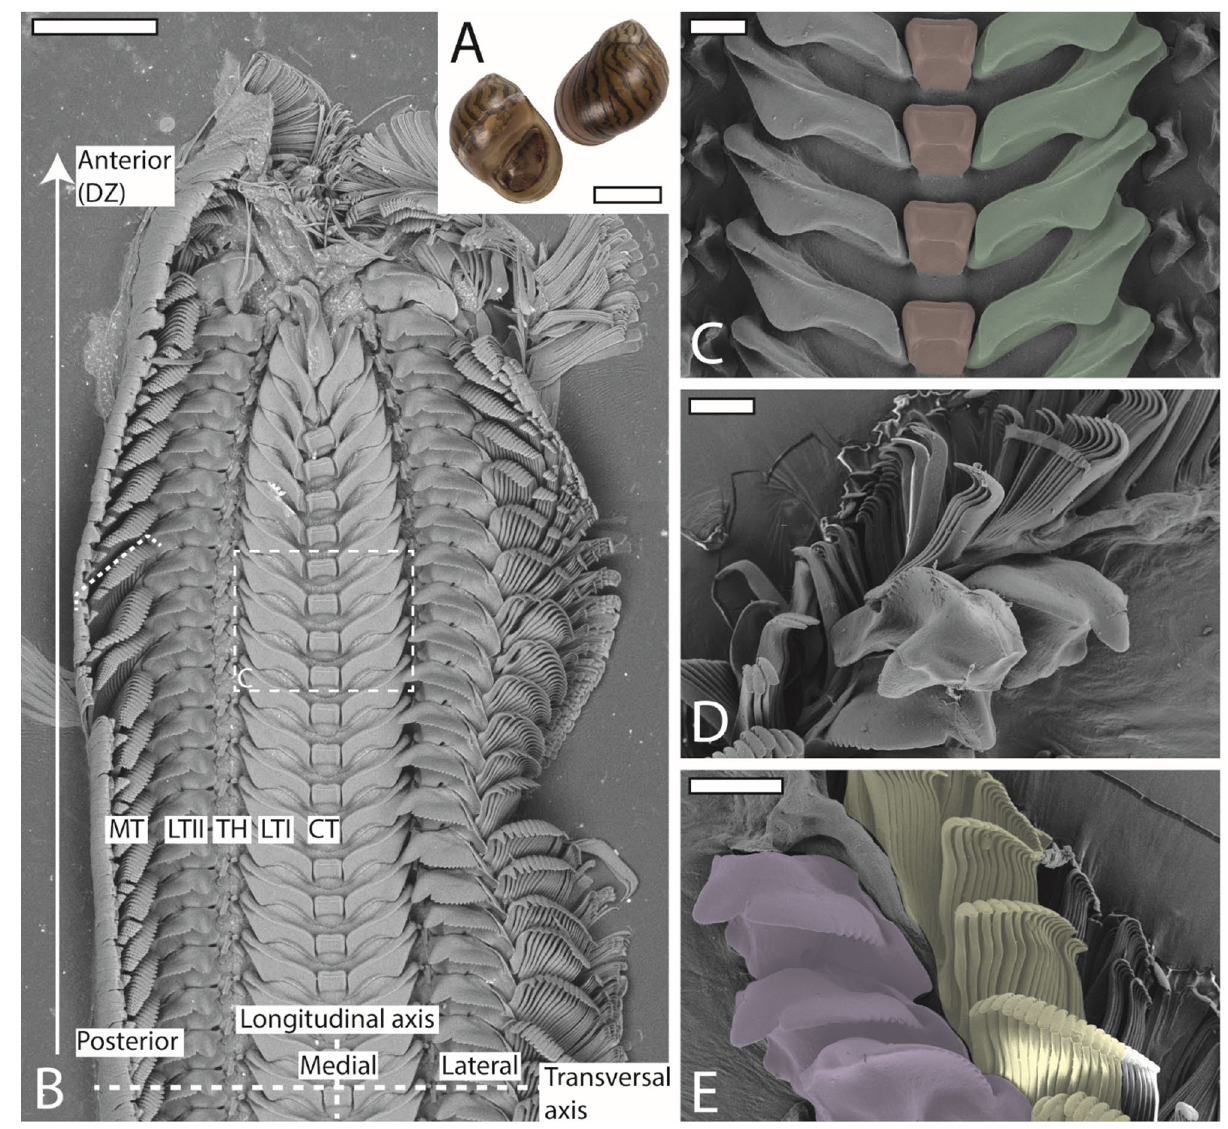
Figure 1. ( A ) Shell of Vittina turrita . ( B – E ) SEM images of one radula from control group. B. Image of outermost part of radula (wear and digestive zone; arrow points in direction of increasing wear) with definition of the anatomical directions (medial, lateral, anterior, posterior) and radular axes (transversal and longitudinal axis). ( C ) Central teeth (red) and lateral teeth I (green). ( D – E ) Lateral tooth II (purple) and inner 15 marginal teeth (yellow) of degenerative zone. CT = central tooth, DZ = degenerative zone, LTI = lateral tooth I, LTII = lateral tooth II, MT = marginal teeth, TH = thickening of membrane/interlocking teeth. Scale bars: A = 30 mm, B = 250 μm, C–E: 60 μm.